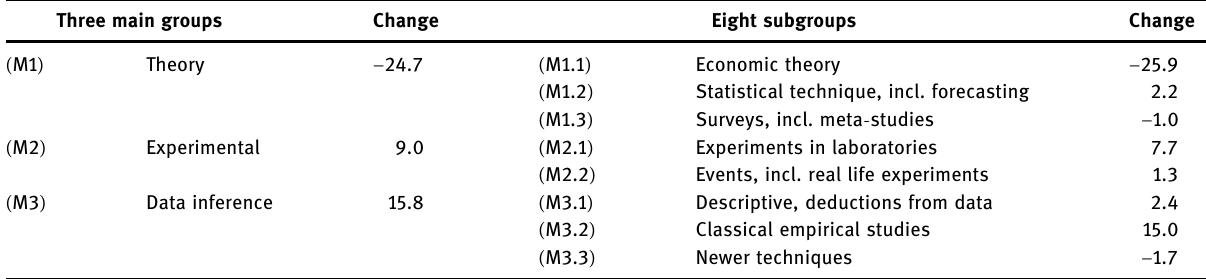
Table 3: The change of the fractions from 1997 to 2017 in percentage points Three main